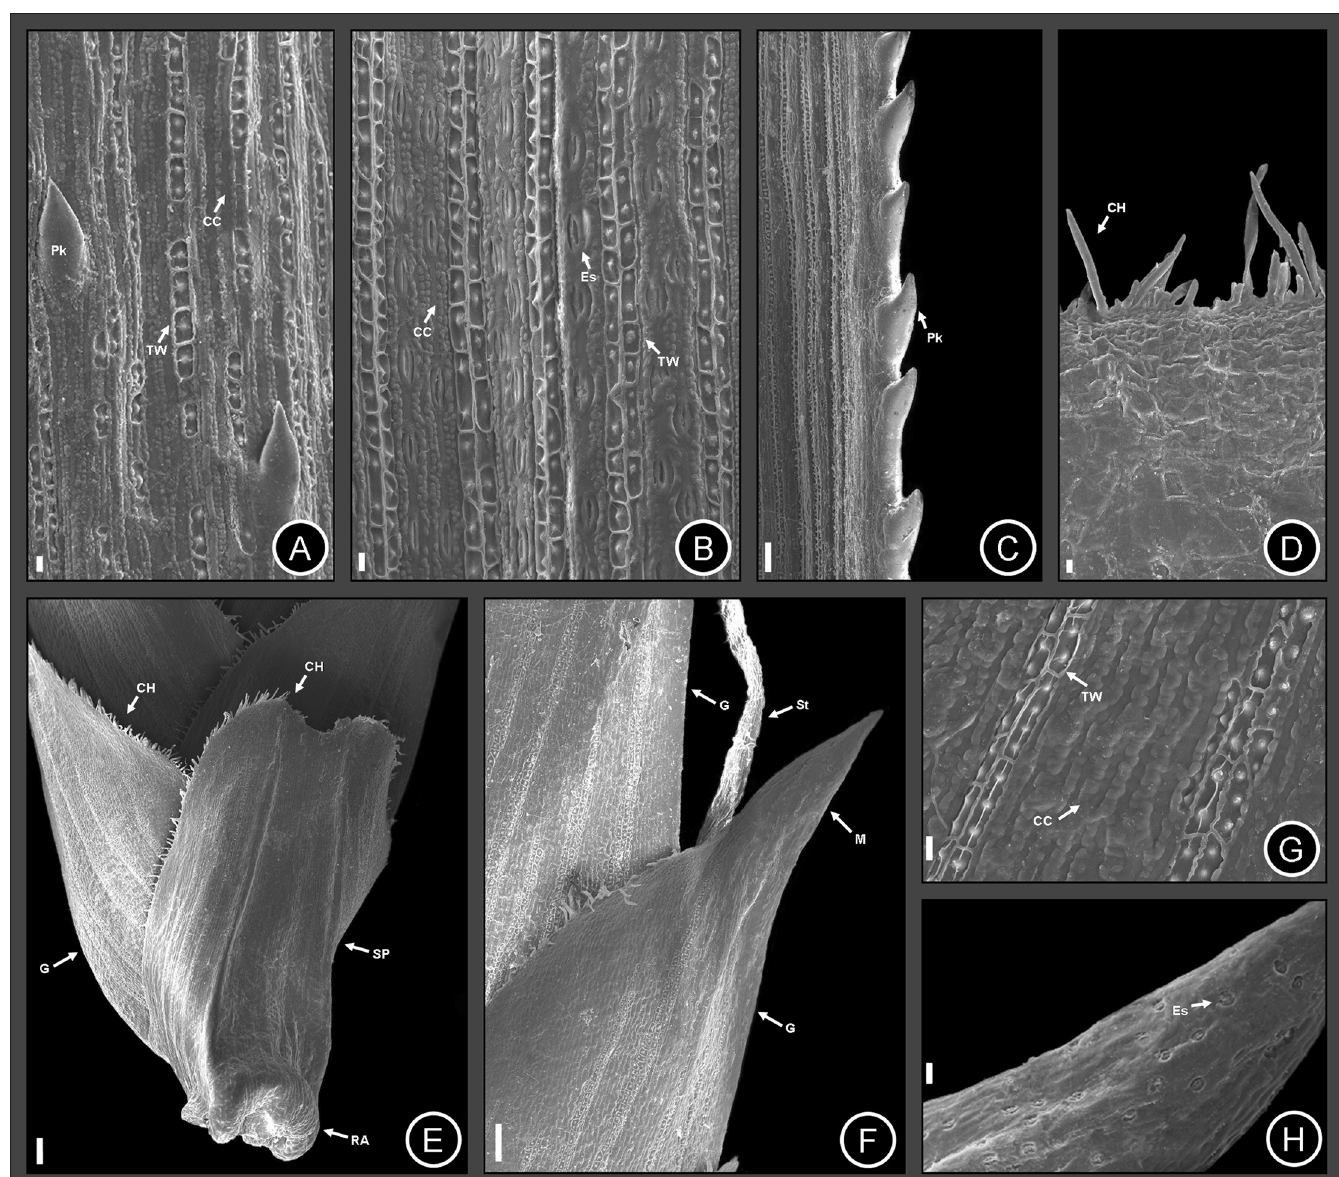
Fig 5. Micrographs taken by Scanning Electron Microscopy (SEM) from leaves and spikelets of Cyperus prophyllatus , sp . nov . Taken from holotype A . R . O . Ribeiro et al . 487 (CVRD). (A–C) Leaf blade. (A) Adaxial surface. (B) Abaxial surface. (C) Leaf blade margin surface viewed from the abaxial side. (D) Ligule surface viewed from the adaxial side. (E) Spikelet prophyll surface viewed from the abaxial side showing a protuberant articulation at base, ciliate single-celled hairs at the margins, and some glumes above the prophyll apex. (F–H) Glume surface viewed from the abaxial side. (F) View of glume showing ciliate single-celled hairs at the margins, the glabrous mucron at the apex, and the style arising from the glume axil. (G) Detail of glume epidermis showing rows of thick-walled epidermal cells tabular or square- shaped and the common epidermal cells. (H) Detail of glume mucron showing stomata. CC = common epidermal cell, CH = ciliate single-celled hair, Es = Stomate, G = Glume, M = mucron, Pk = prickle, RA = rachilla articulation, SP = spikelet prophyll, St = Style, TW = thick-walled epidermal cell. Scale bars: A, B, D, G = 10 μ m. C = 50 μ m. E–F = 100 μ m. H = 20 μ